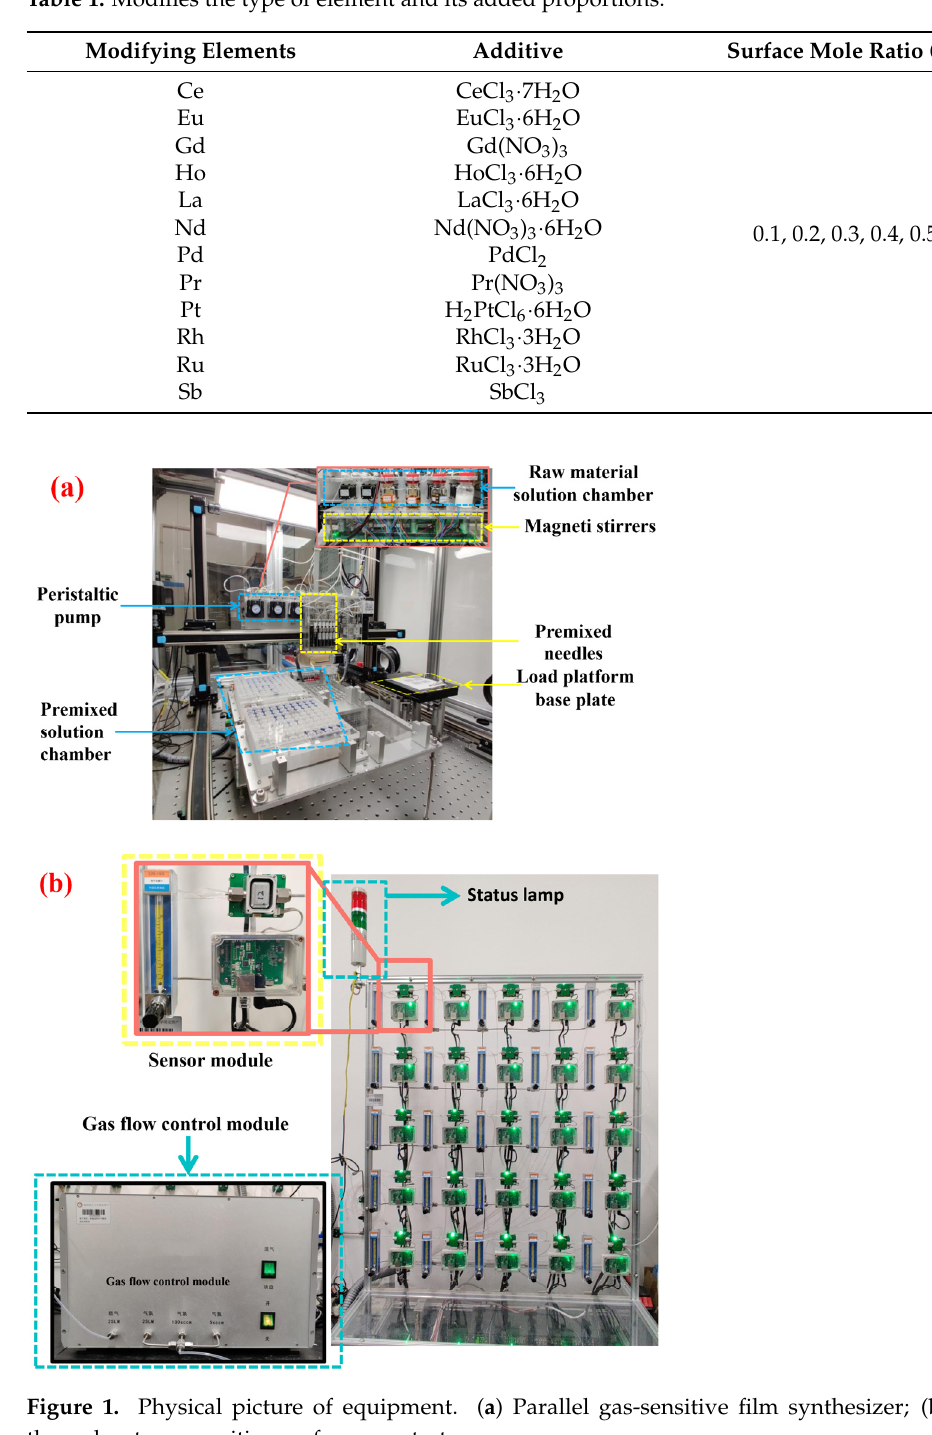
Table 1. Modifies the type of element and its added proportions.